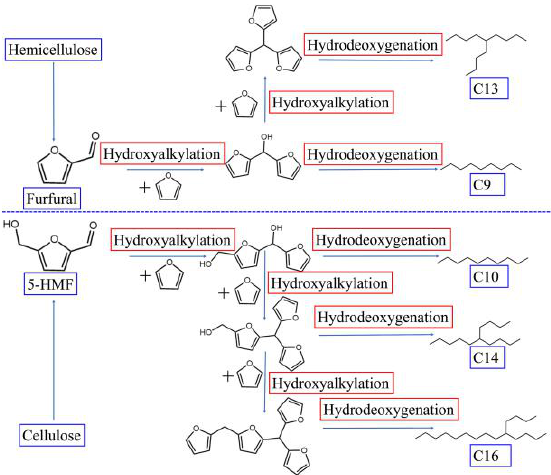
Figure 8. Production of aviation fuels from carbohydrate-derived furanic intermediates via hydrox- yalkylation/alkylation (HAA) and hydrodeoxygenation (HDO) reactions [162].